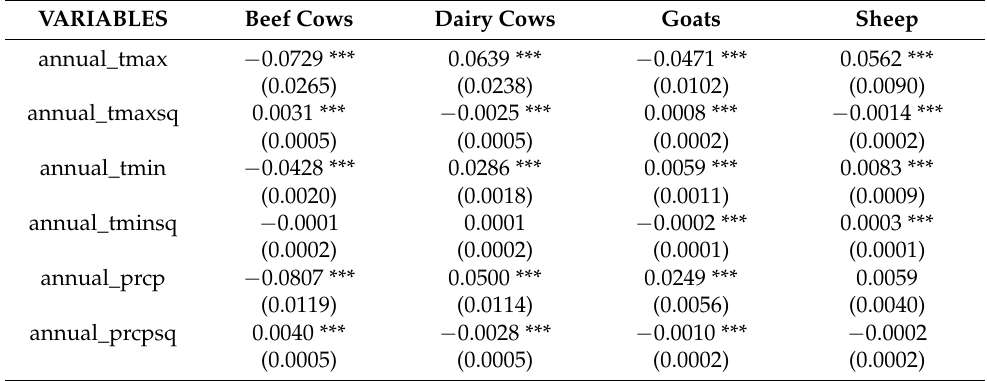
Table 6. Average marginal effects on land share in Eastern